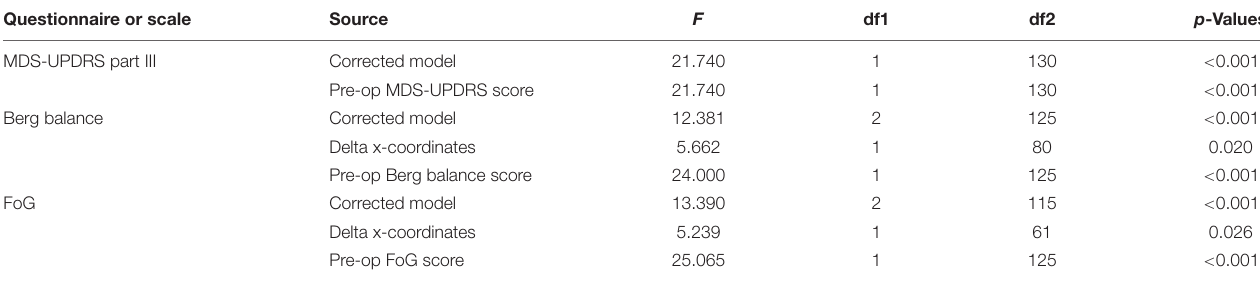
TABLE 1 | Fixed effects of the generalized linear mixed model for the scores of MDS-UPDRS part III, Berg balance, and freezing of gait (FoG), respectively. Questionnaire or